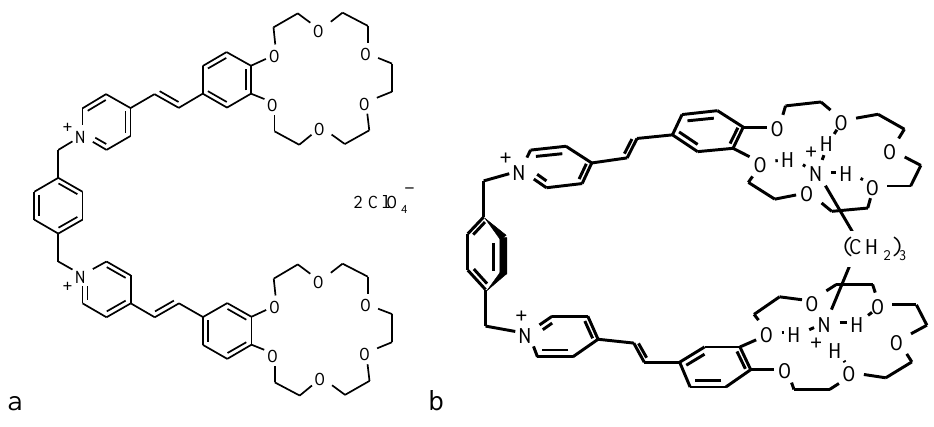
Figure 9. Structure of OMS-5 ( a ) and scheme of the 1:1 complex between OMS-5 and 1,3-propanediammonium ion ( b ).